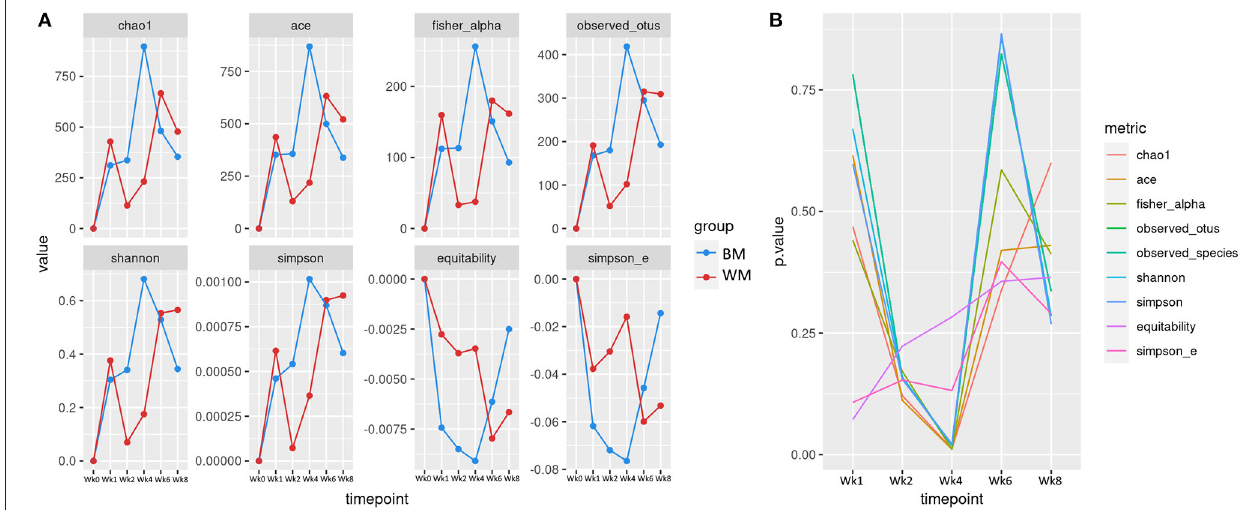
FIGURE 2 | (A) Alpha diversity indices at the different trial time points for the two groups: bulk tank milk (BM) and waste milk (WM). Index values are indicated as differences from baseline (Wk0 = 0). (B) Statistical significance of alpha diversity indices at the various time points.